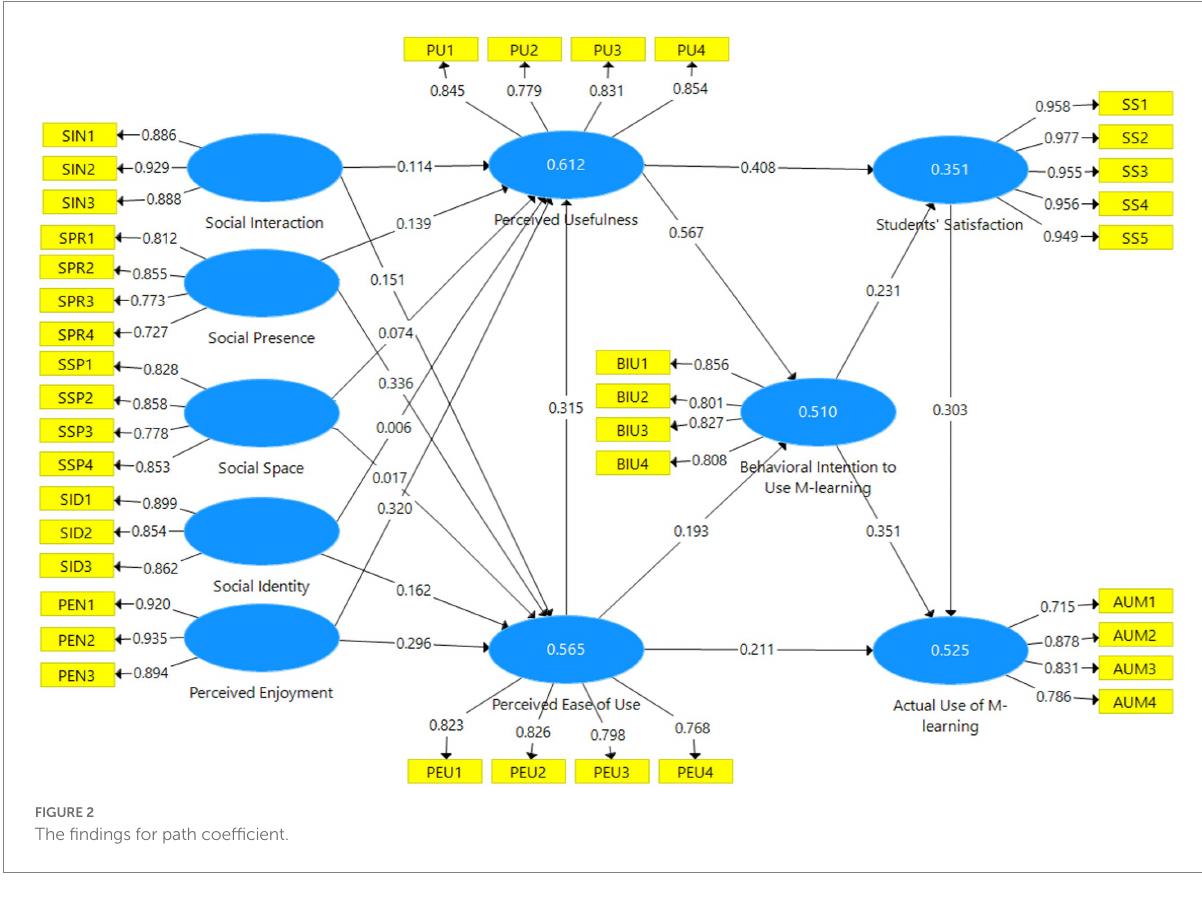
TABLE 8 Summary of hypotheses testing